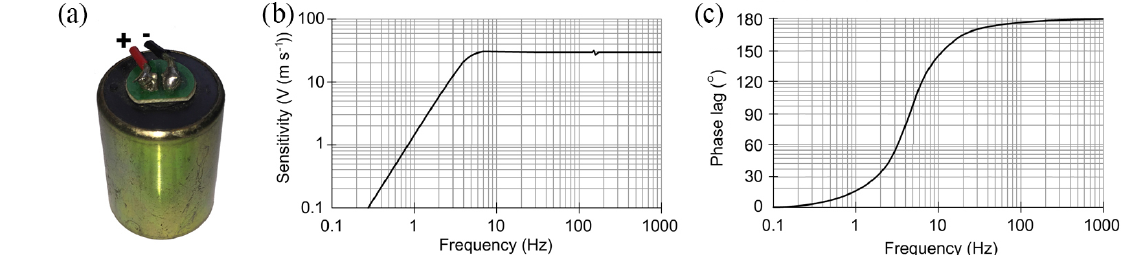
Figure 2. For the geophones with a 4.5Hz natural frequency, (a) external view, (b) amplitude response, and (c) phase response.